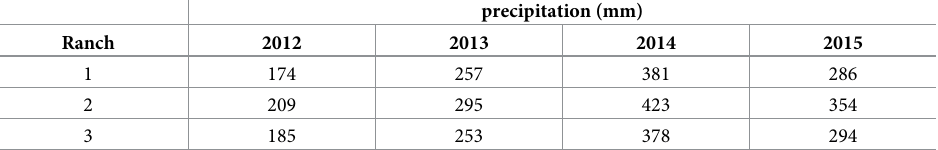
Table 2. Annual precipitation (mm) for the three Pinedale, WY area ranches over the course of the experiment, 2012–2015. Precipitation values were derived using interpolated values from the PRISM Climate Group, Oregon State